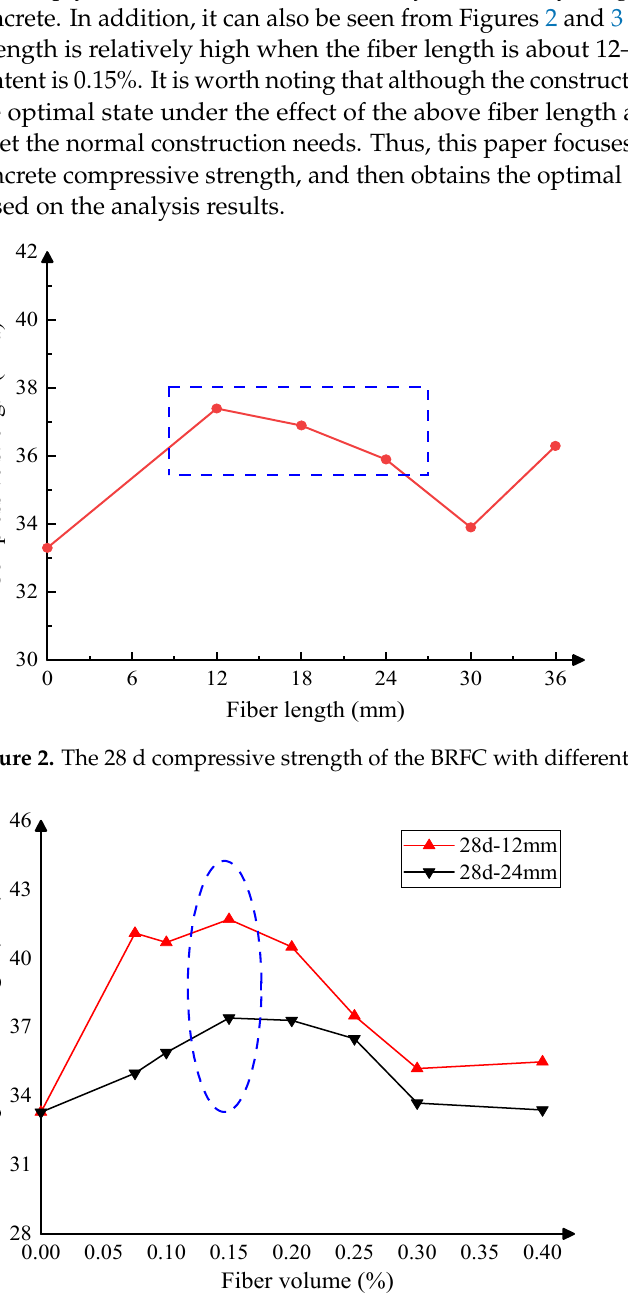
Figure 3. The compressive strength of the BRFC with different fiber volume contents.